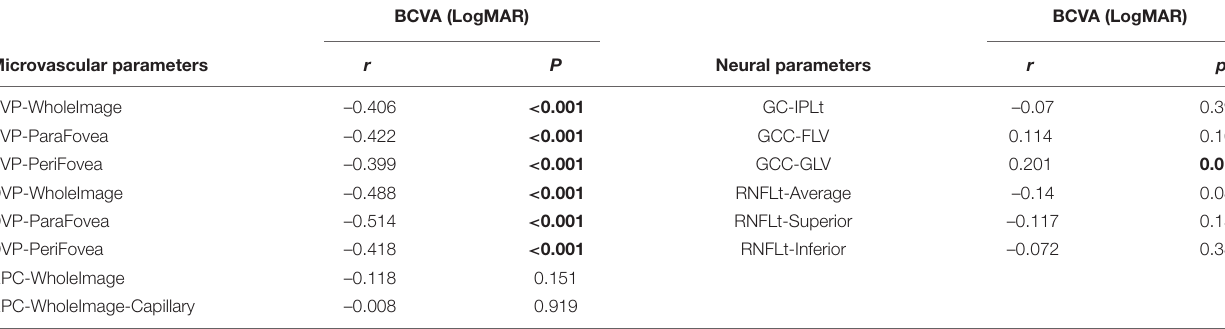
TABLE 6 | Correlations of retinal neurovascular parameters and BCVA